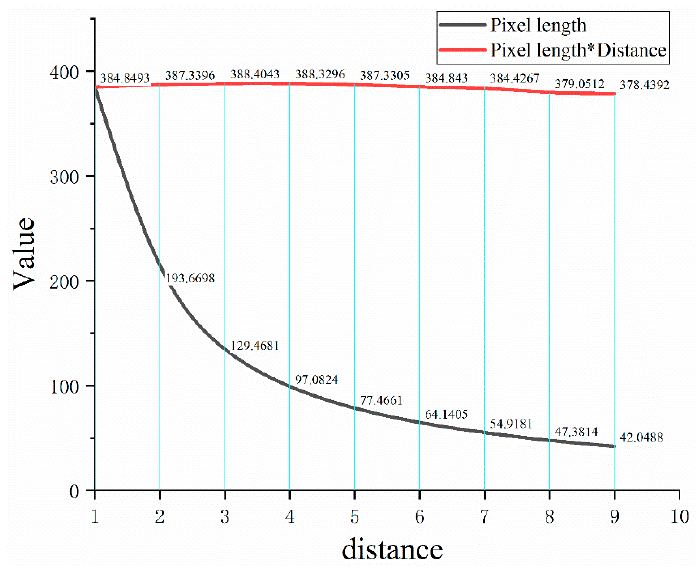
Figure 11. Trend between pixel length and distance.